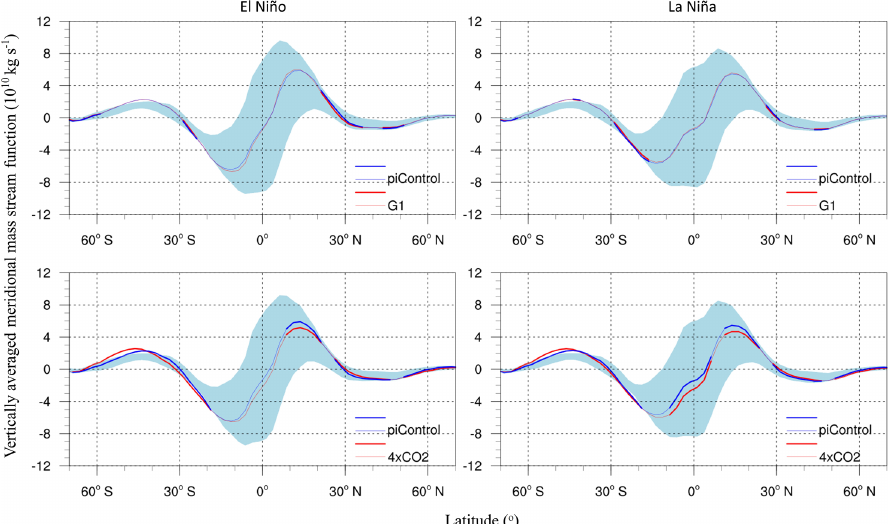
Figure 10. The vertically averaged meridional mass stream function under ENSO. For El Niño or La Niña conditions, the blue line in each panel represents the vertically averaged zonal mass stream function (10 10 kgs − 1 ) under piControl. The red line in the top row is G1 and the bottom row is abrupt4xCO2. The thick lines denote locations where circulation changes are significant at the 95% confidence level. The 16–84% range across the eight individual models is shown by light blue